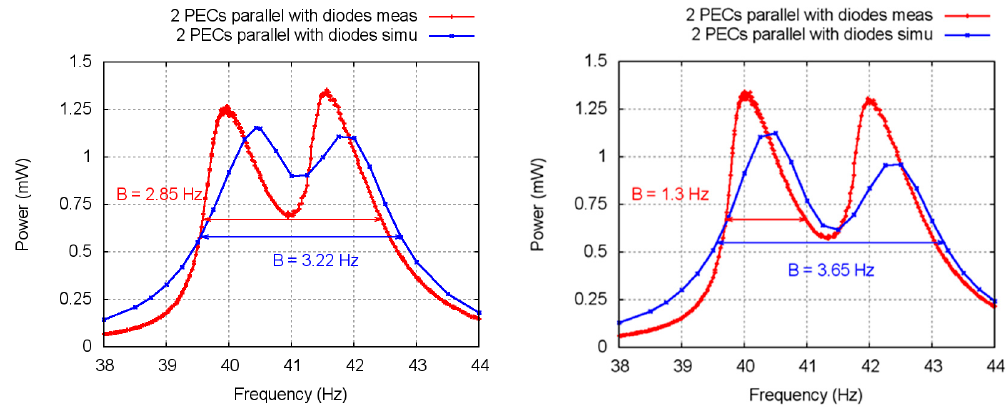
Figure 14. Comparison of the simulated and measured power with dependence upon frequency for the parallel connection of two PECs with individual rectifiers and ∆ f = 1.5 Hz ( left ) or ∆ f = 2 Hz ( right ).